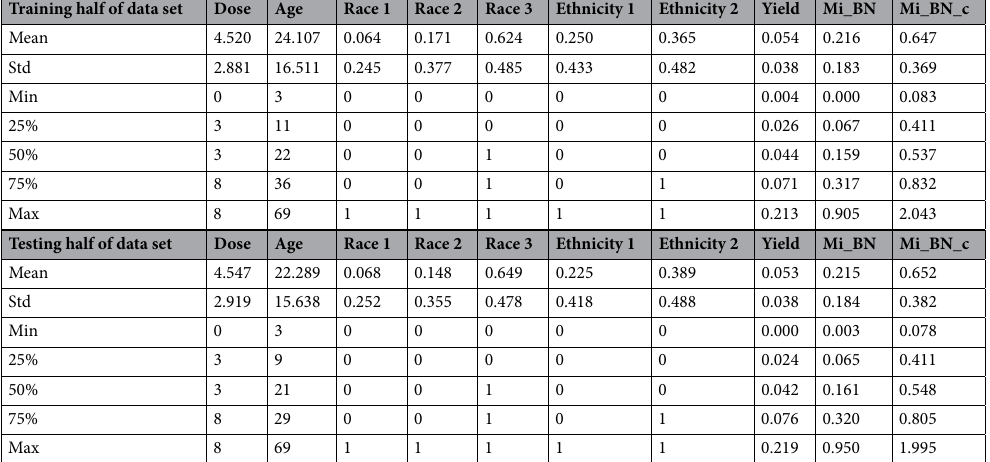
Table 1. Summary statistics for the training and testing halves of the analyzed data set. There were 561 samples in each half. As described in the main text, Dose is the radiation dose (Gy) to which each sample was exposed, Age is the age of the subject (years), Yield is the dicentrics yield, Mi_BN and Mi_BN_c are the raw and corrected micronuclei indeces. Race and Ethnicity are categorical variables, so they were converted into columns of binary variables by one-hot